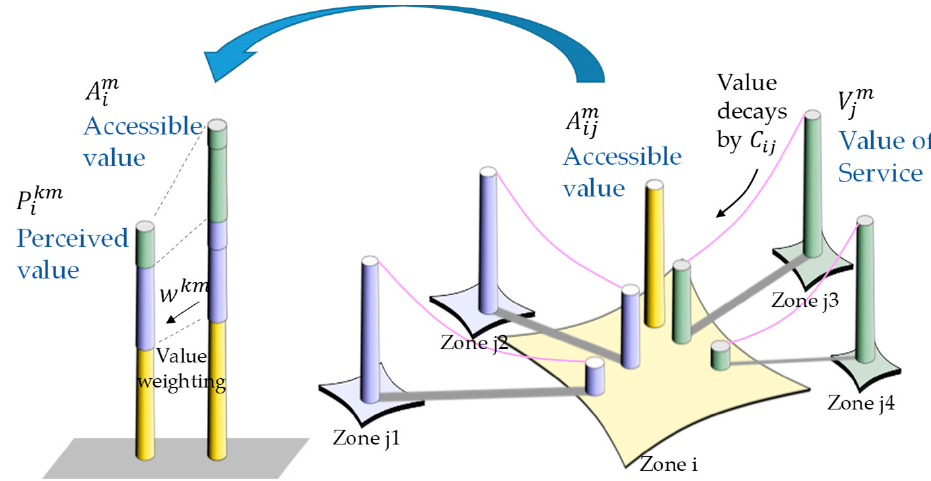
Figure 3. The model of the QOL accessibility method.